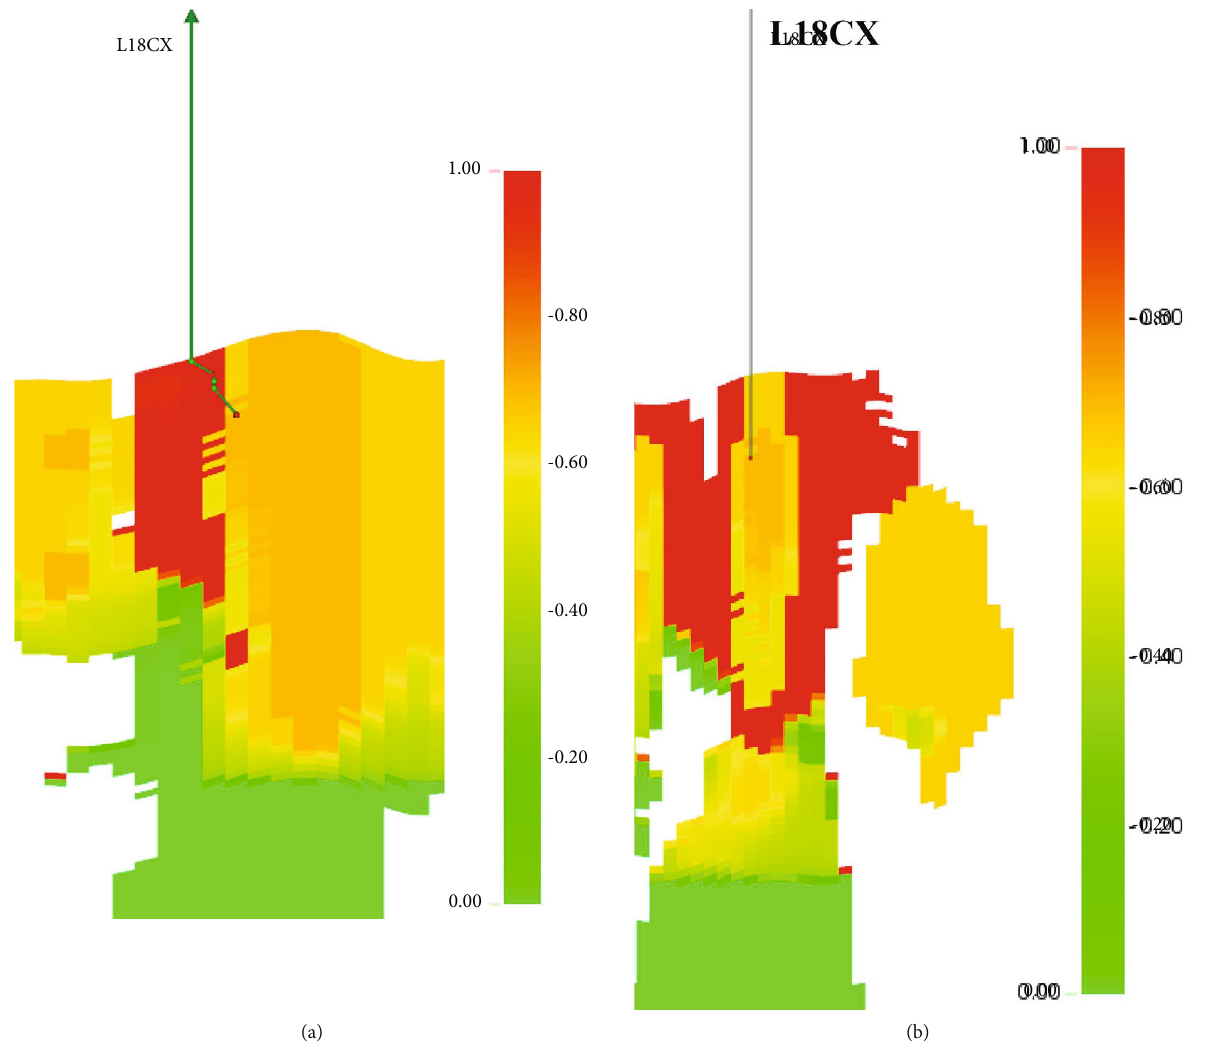
Figure 8: Residual oil distribution characteristics of the well